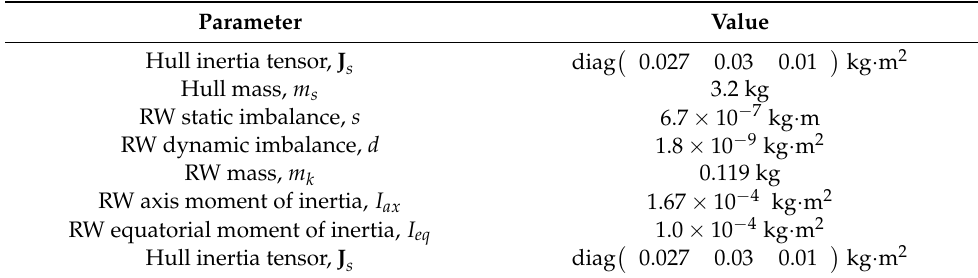
Table 1. System parameters.